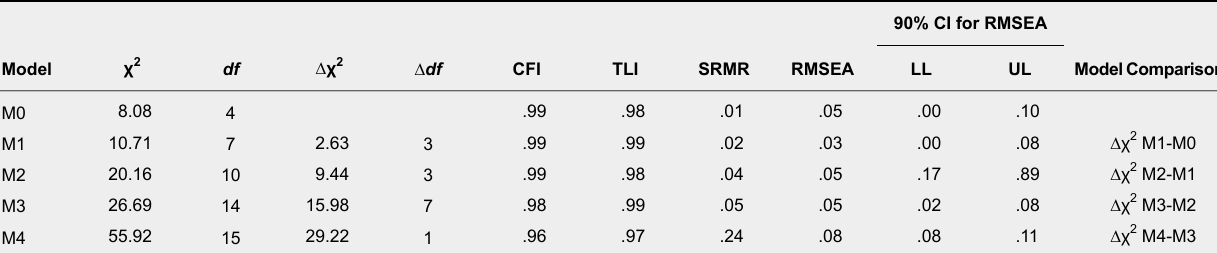
Goodness-of-fit Indices and Comparison of Models Testing Measurement Invariance for Perceived Repression